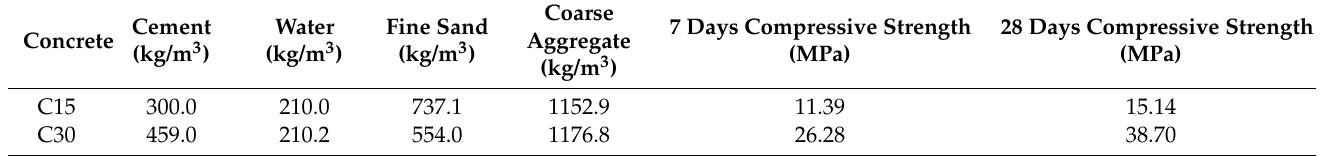
Table 1. The mixture ratio and mechanical properties of